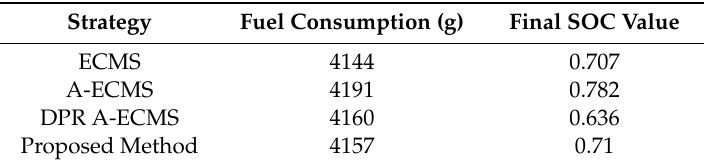
Table 4. Comparison of the fuel consumption and final SOC.